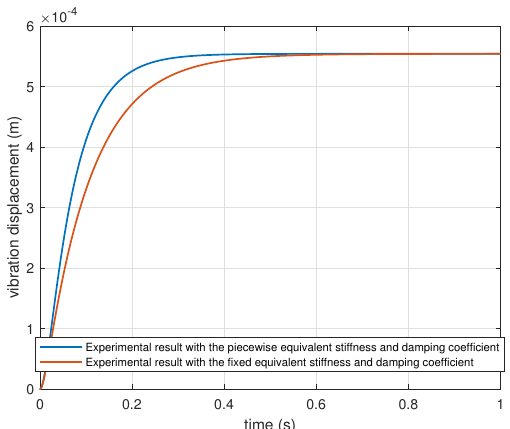
Figure 9. Experimental results of two active control